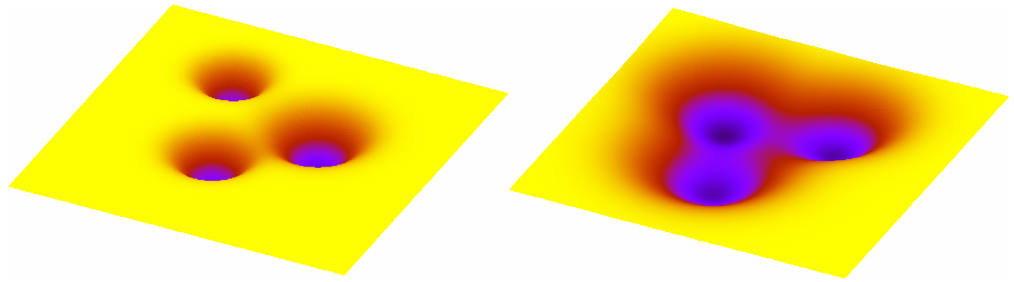
Figure 4. Transition probabilities can be instructively visualised by the heights of the barriers which separate areas corresponding to stable cell types. Higher barriers correspond to more restrictive (i.e., less plastic) epigenetic landscape ( left panel ), while the lower barriers ( right panel ) correspond to more permissive